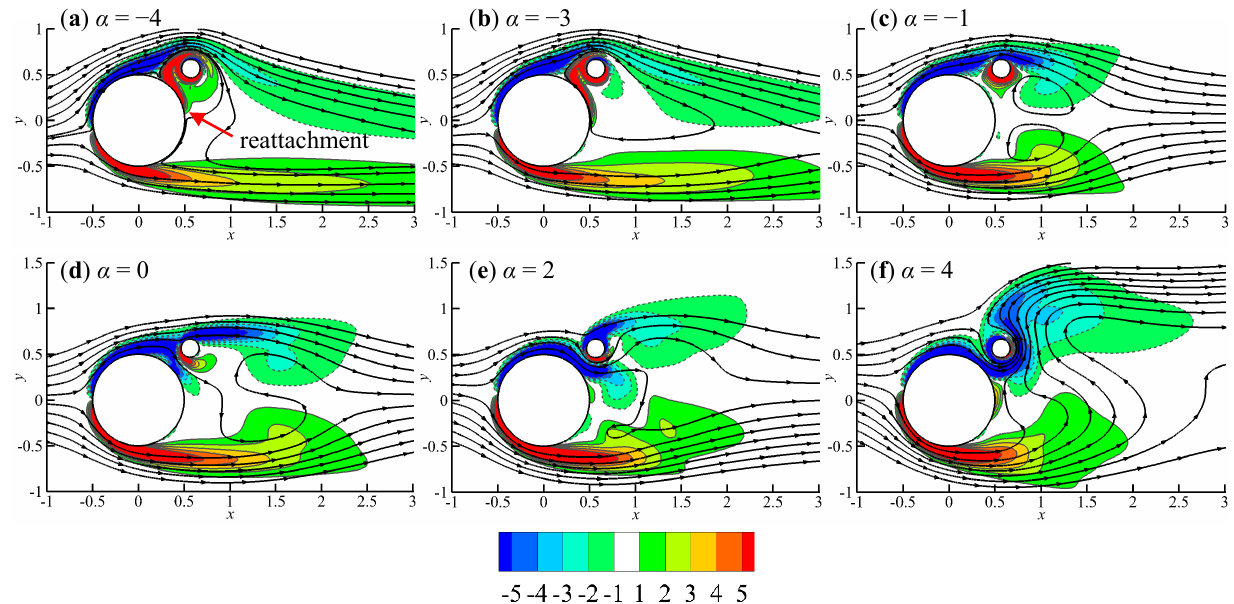
Figure 5. Streamlines and the contours of the nondimensional vorticity of the mean flow for β = 45°.